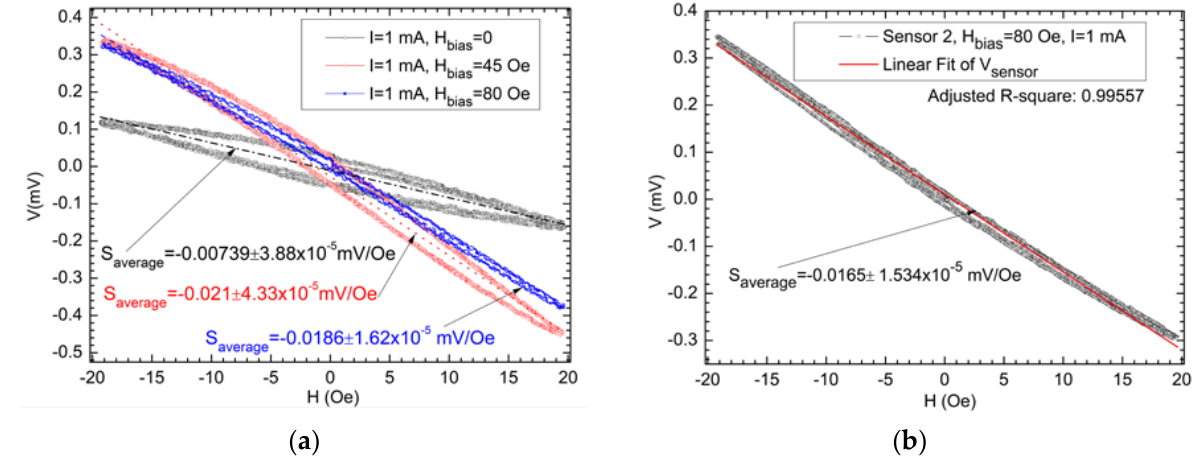
Figure 15. Thermally and magnetically cured AMR bridge sensor, field characteristics at different biasing levels ( H bias = 0, 45, 80 Oe): ( a ) Field characteristics for sensor 1; ( b ) Field characteristics for sensor 2 H bias = 80 Oe bias